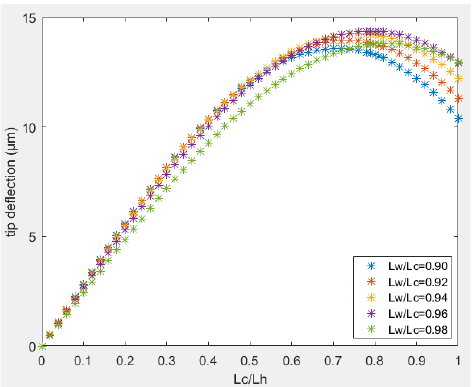
Figure 14. Tip deflection of design C in function of length ratio between two arm structures and the